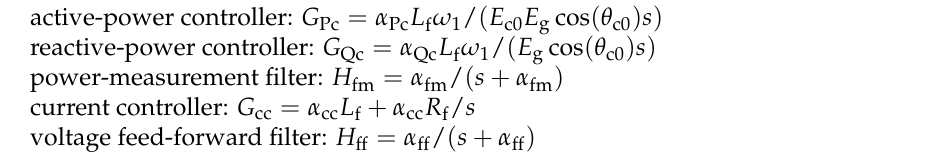
( V base ) and with the base impedance given by Z base = V 2 bandwidth in rad/s for active power, reactive power, current, measurement filter, and feed-forward filter as α Pc , α Qc , α cc , α fm , and α ff , respectively, are used as design parameters.